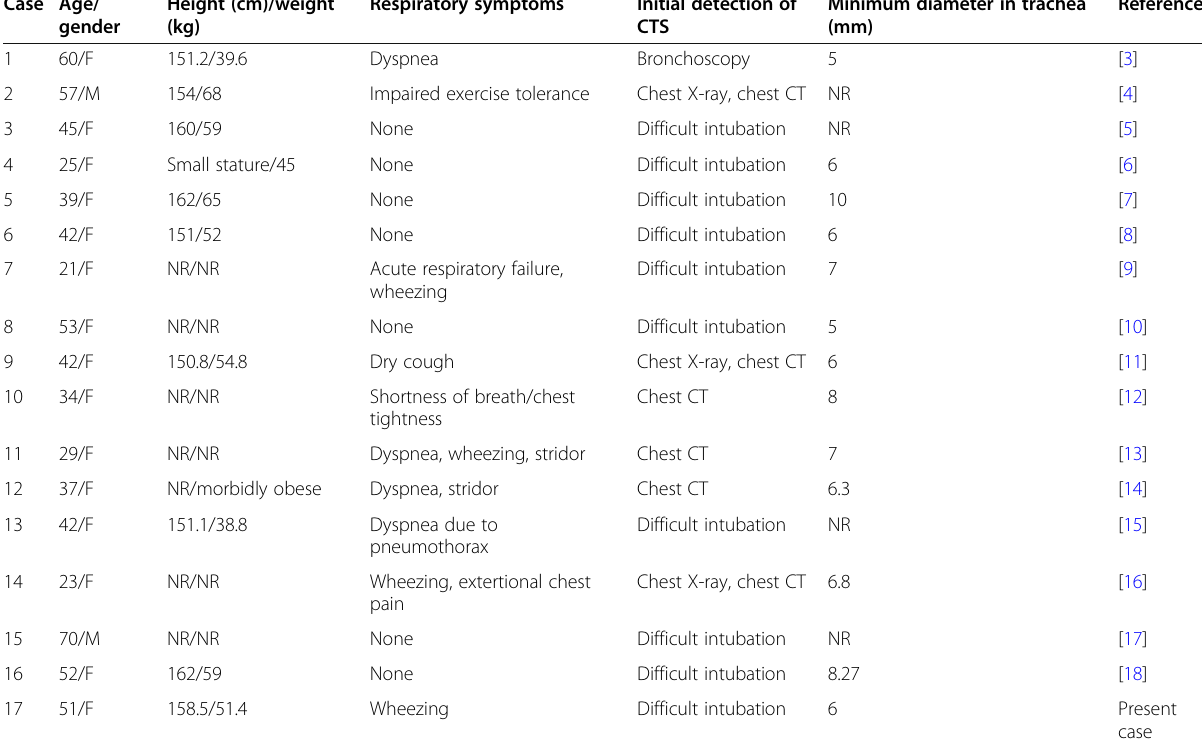
Table 1 Reported cases of congenital tracheal stenosis diagnosed in adulthood Case Age/